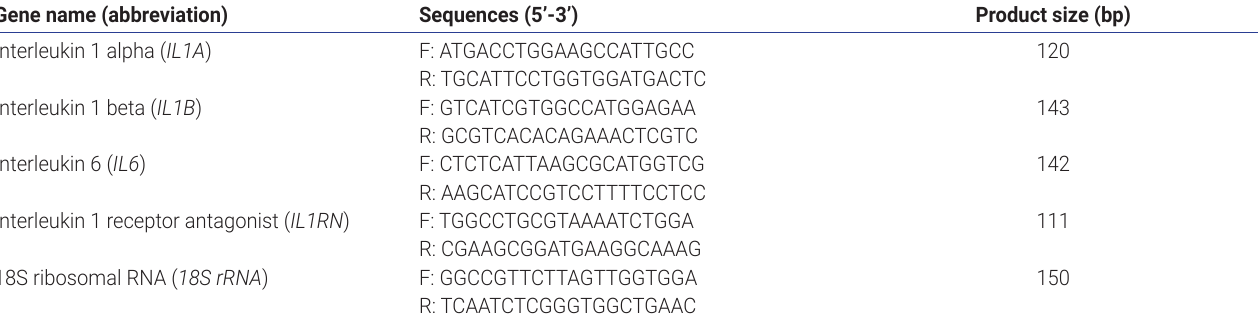
Table 2. Primer sequences and amplicon information for real-time polymerase chain